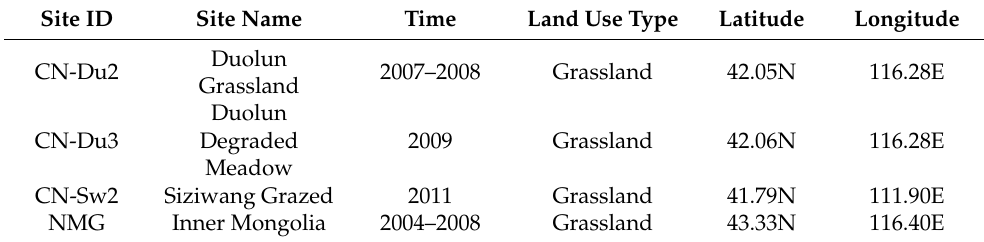
Table 2. Description of FLUXNET sites in Inner